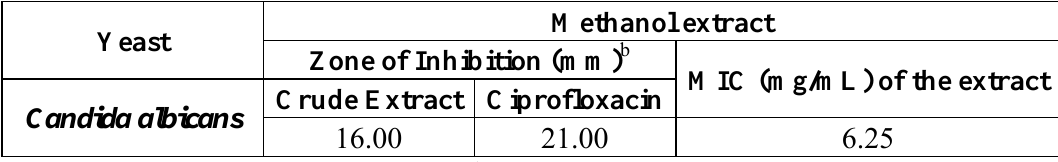
Table 2. Anti-yeast activity (zone of inhibition and MIC a ) of Elaies guineensis extract compared with commercial antibiotic